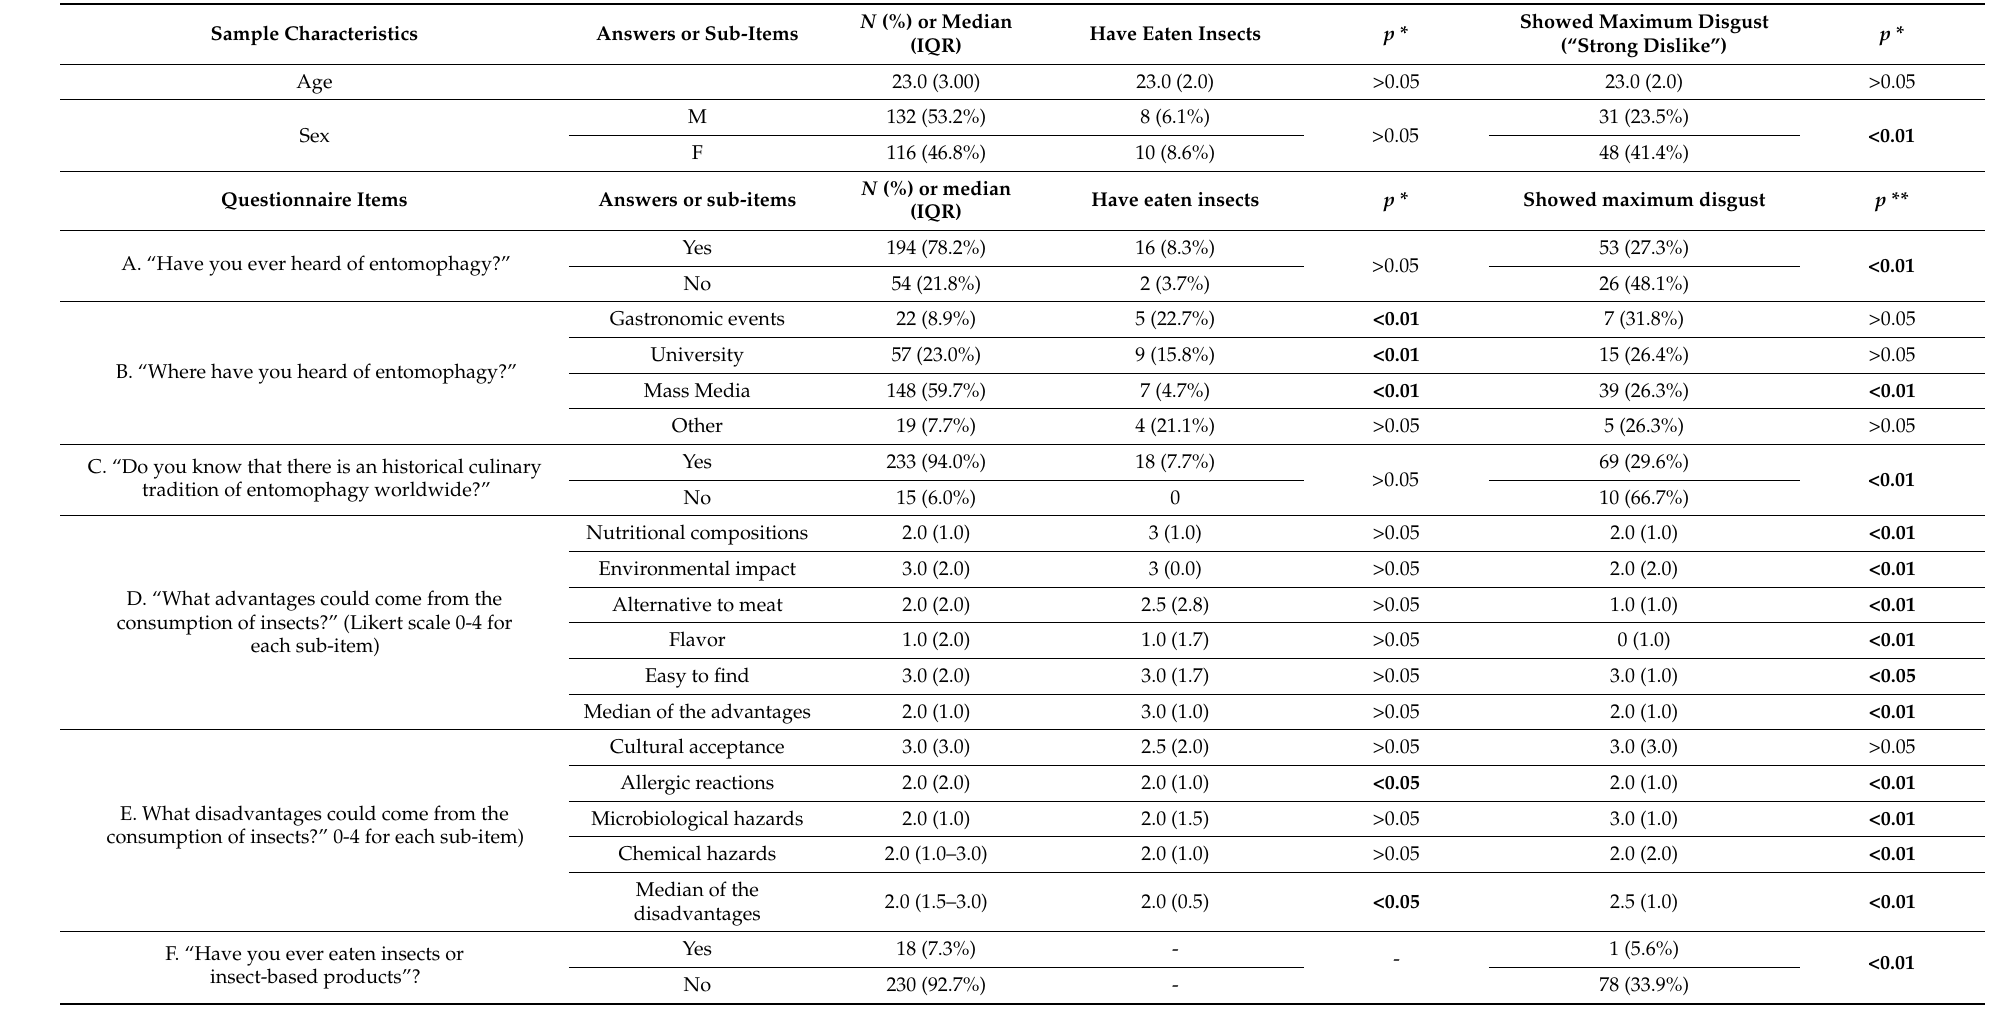
Table 1. Questionnaire answer frequencies and univariate analysis between each item and the chosen